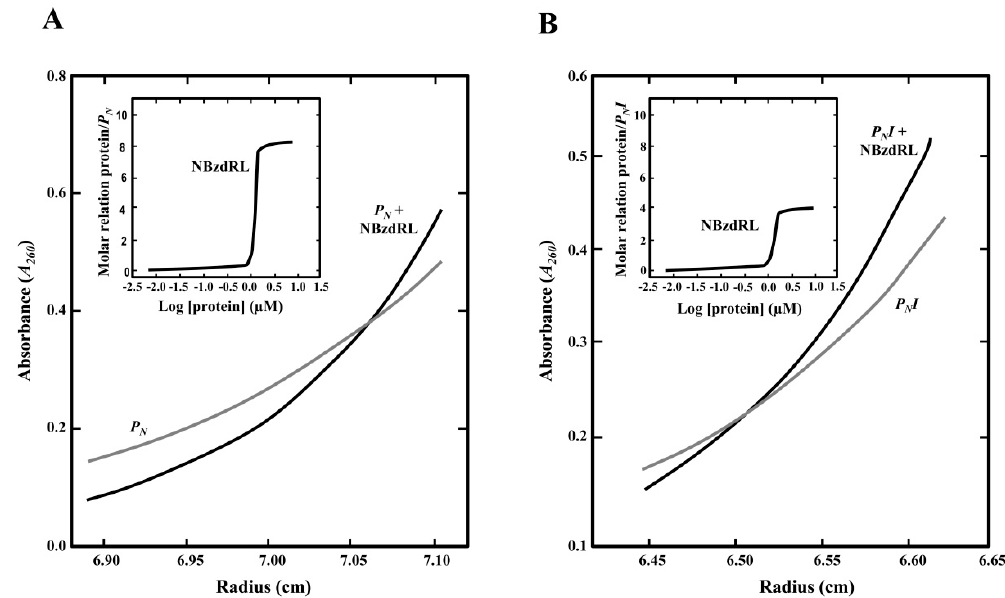
Figure 6. Sedimentation equilibrium analysis to study the interaction of purified NBzdRL protein with P N and P N I DNA fragments. ( A ) Distribution of the gradient in sedimentation equilibrium of the P N fragment ( P N , gray line) or P N fragment with His 6 -NBzdRL protein (black line). The inset graph shows the protein / DNA molar ratio as the concentration of His 6 -NBzdRL increases. ( B ) Distribution of the gradient in sedimentation equilibrium of the P N I fragment (gray line) and P N I + His 6 -NBzdRL complex (black line). The inset graph shows the protein / DNA molar ratio as the concentration of NBzdRL increases.